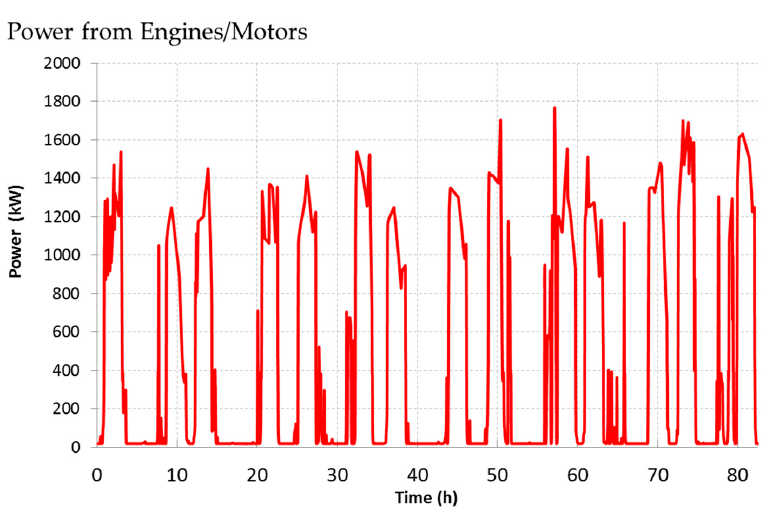
Figure 19. Ship transition route speed profile of a SWATH II type ship.